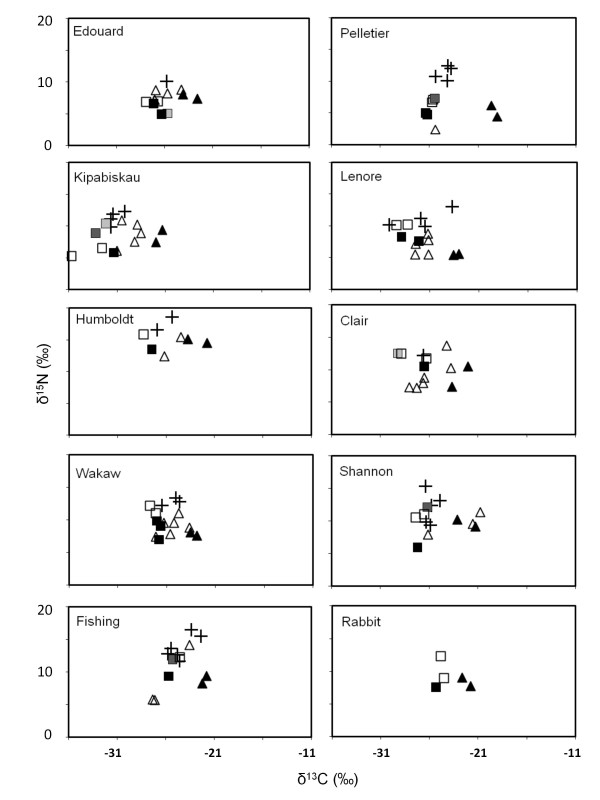
A and B: Stable isotope bi-plots for the 20 study lakes, with δ15N on the Y-axis and δ13C on the X-axis. Lakes are sorted by salinity (see Table 1), increasing within rows from row 1 to row 10. Data are averaged over the four sampling dates (June 2007, August 2007, June 2008, August 2008). Fish taxa are indicated by crosses (+), zooplankton by squares (□), and littoral invertebrate by triangles (Δ). Zooplankton is further separated into cladocerans (black squares, ■), copepods (open squares, □), invertebrate predators (i.e., Leptodora or Chaoborus; dark grey squares, ■) and other macroinvertebrates (e.g., corixids; light grey squares, ■). Within littoral invertebrates, amphipods are indicated by black triangles (▲).